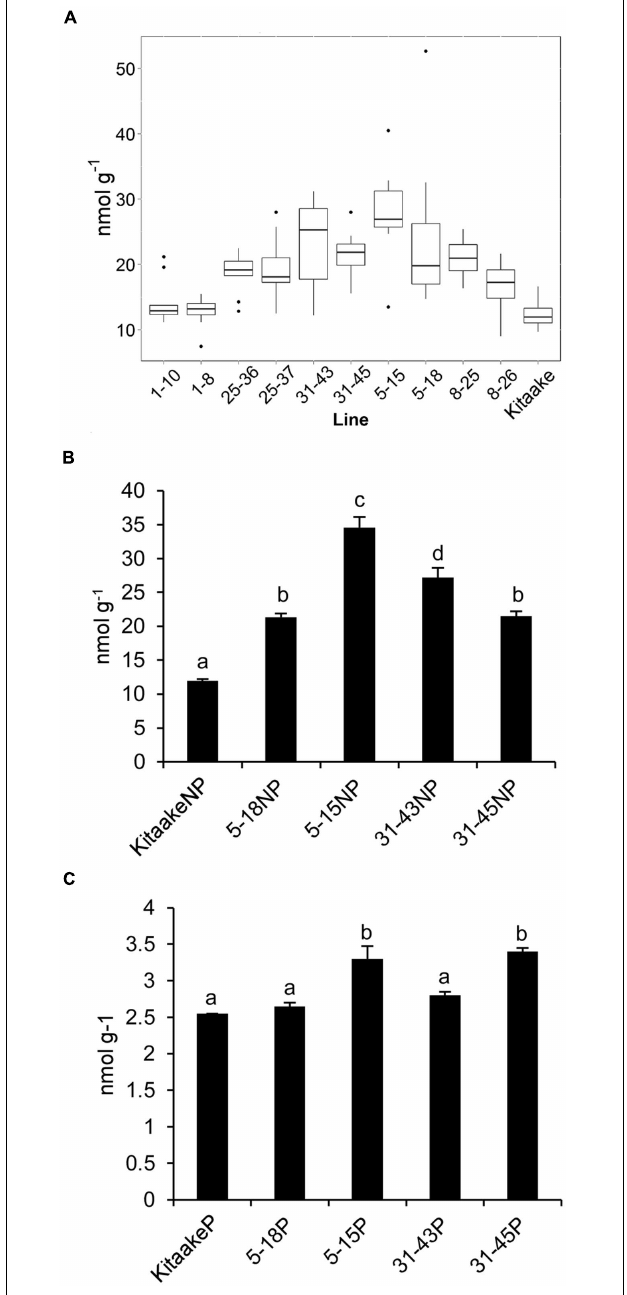
FIGURE 6 | Thiamin concentrations in F 3 seeds of THI1 × THIC lines. (A) Boxplot representation of thiamin concentrations in 10 to 12 individual unpolished seeds of several independent THI1 × THIC lines. (B) Thiamin concentrations in unpolished (NP) seeds of Kitaake and several independent THI1 × THIC lines. Twenty unpolished seeds per genotype were pooled and reduced to powder for thiamin analysis. Data are means ± SE of three determinations. (C) Thiamin concentrations in polished (P) seeds of Kitaake and several independent THI1 × THIC lines. Twenty seeds per genotype were polished, pooled, and reduced to powder for thiamin analysis. Data are means ± SE of three determinations. Identical letters indicate that there was no significant difference between samples as determined by ANOVA ( p > 0.05).